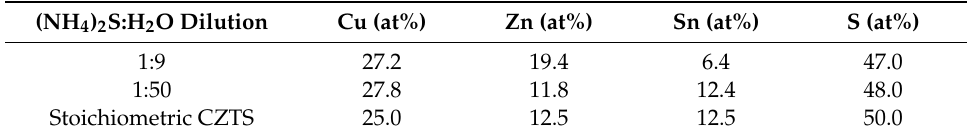
Figure 8. CZTS film produced using nanoink with (NH 4 ) 2 S:H 2 O dilution of 1:50 and nanoparticle concentration of 170 mg/mL. ( a ) Planar view, ( b ) Cross-section view. Table 1. Normalized EDS composition values for constituent CZTS film elements at di ff erent dilution levels of (NH 4 ) 2 S:H 2 O, standard solid concentration of 170 mg /